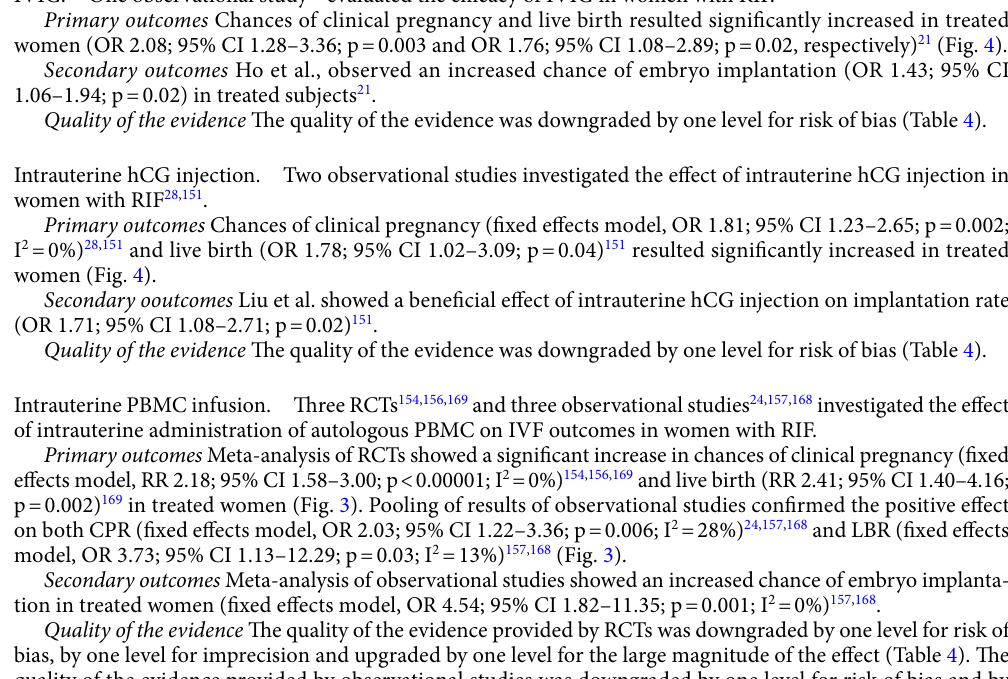
Figure 4. ( A ) Effect of intentional endometrial injury on CPR in women with RIF (RCTs). ( B ) Effect of intentional endometrial injury on LBR in women with RIF (RCTs). ( C ) Effect of intentional endometrial injury on CPR in women with RIF (observational studies). ( D ) Effect of hysteroscopy on LBR in women with RIF (RCT). ( E ) Effect of atosiban on CPR in women with RIF (observational study). ( F ) Effect of sequential ET on CPR in women with RIF (RCT). ( G ) Effect of sequential ET on CPR in women with RIF (observational studies). ( H ) Effect of PGT-A on CPR in women with RIF (RCTs). ( I ) Effect of PGT-A on LBR in women with RIF (RCTs). ( J ) Effect of PGT-A on CPR in women with RIF (observational studies). ( K ) Effect of PGT-A on LBR in women with RIF (observational studies). ( L ) Effect of ZIFT on CPR in women with RIF (observational studies). ( M ) Effect of ZIFT on LBR in women with RIF (observational studies). ( N ) Effect of AH on CPR in women with RIF (RCT). ( O ) Effect of AH on LBR in women with RIF (observational study). ( P ) Effect of intravenous intralipid on CPR (RCT). ( Q ) Effect of intravenous intralipid on LBR in women with RIF (RCT). ( R ) Effect of LMWH on CPR in women with RIF (RCTs). ( S ) Effect of LMWH on LBR in women with RIF (RCT). ( T ) Effect of LMWH on CPR in women with RIF (observational study). ( U ) Effect of LMWH on LBR in women with RIF (observational study). ( V ) Effect of IVIG on CPR in women with RIF (observational study). ( W ) Effect of IVIG on LBR in women with RIF (observational study). ( X ) Effect of intrauterine hCG infusion on CPR in women with RIF (observational studies). ( Y ) Effect of intrauterine hCG infusion on LBR in women with RIF (observational study). ( Z ) Effect of intrauterine PRP infusion on CPR in women with RIF (RCT). ET embryo transfer, RIF repeated implantation failure, RCT randomized clinical trial, CPR clinical pregnancy rate, LBR live birth rate, LMWH low molecular weight heparin, PGT-A preimplantation genetic testing for aneuploidy, IVIG intravenous immunoglobulin, hCG human chorionic gonadotropin, ZIFT zygote intrafallopian transfer, AH assisted hatching, PRP platelet rich